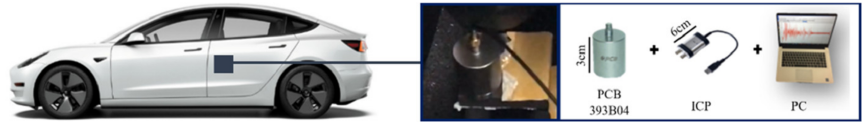
Figure 7. Test vehicle and the equipment used.